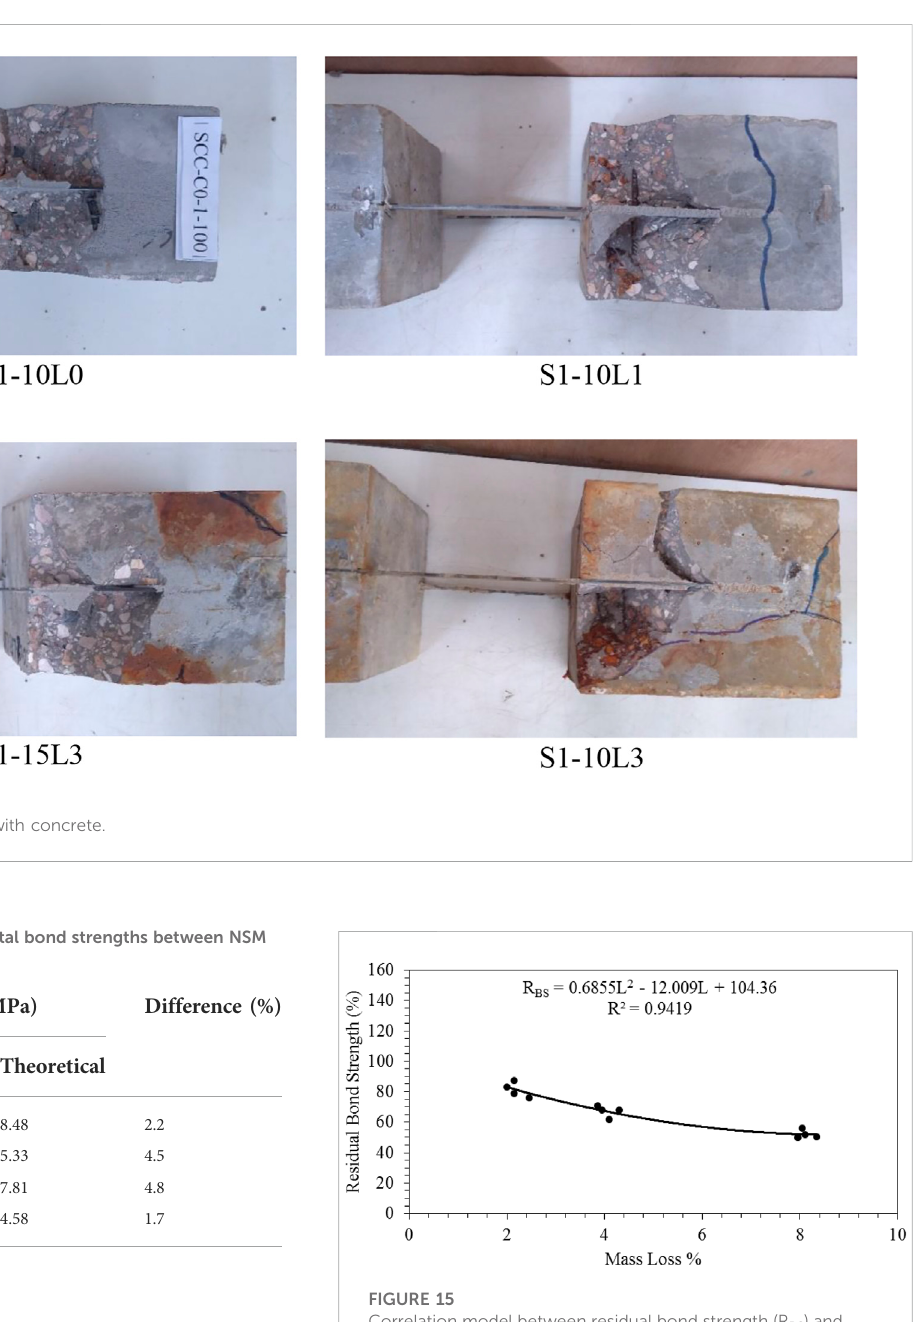
FIGURE 15 Correlation model between residual bond strength (R BS ) and mass loss